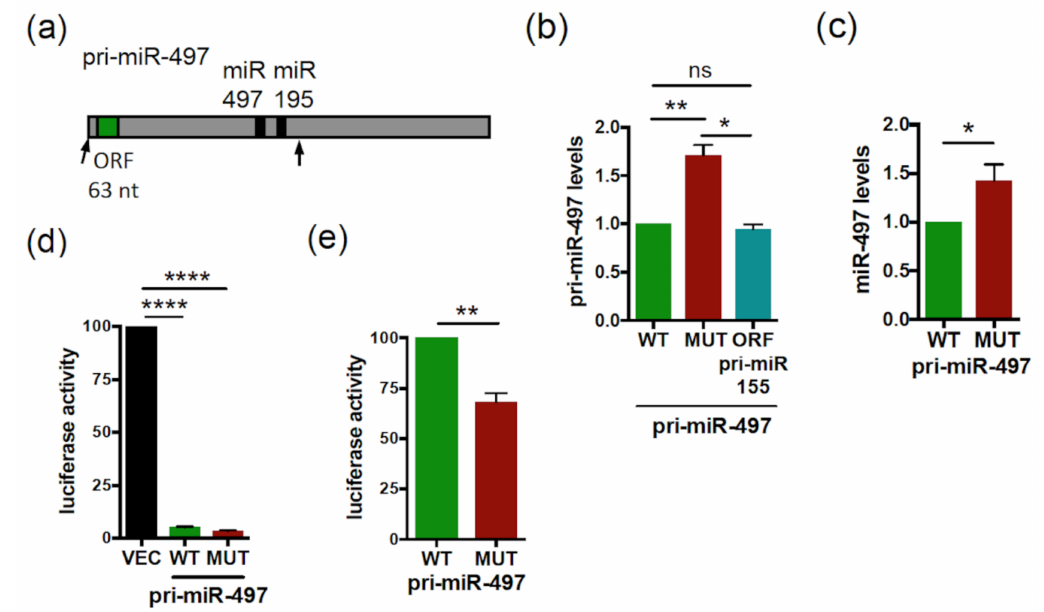
Figure 2. The smORF63 of Human pri-miR-497 regulates the expression levels and activity of pri- miR-497/miR-497. ( a ) Schematic structure of Human pri-miR-497 with the miR-497 (black box) and smORF63 (green box) indicated. The arrows in the pri-miR-497 delimit the sequences cloned and tested. ( b ) Relative expression levels of pri-miR-497 WT or ATG-mutated (MUT) or with the smORF63 replaced by the smORF51 from pri-miR-155 (ORF pri-miR-155) transfected in Hela cells and determined by qRT-PCR. The pri-miR-497 levels were determined and normalized as in Figure 1b. Data are means ± S.E.M. n = 4. ( c ) Relative expression levels of miR-497 processed from WT or MUT pri-miR-497 transfected into Hela cells and determined by qRT-PCR. The miR-497 levels were normalized as in Figure 1b. Data are means ± S.E.M. n = 7. ( d , e ) Relative activity of miR-497 processed from the WT or MUT pri-miR-497 constructs transfected in Hela cells together with the luciferase miR-497 sensor. Cells were tested 48 h post-transfection for dual luciferase assays. ( d ) The luciferase activities of pri-miR-497 transfected cells were compared to that of vector transfected cells (VEC), set to 100. ( e ) The relative luciferase activity of MUT pri-miR-497 was compared to that of WT pri-miR-497 set to 100. Data are means ± S.E.M. n = 8. * p < 0.05, ** p < 0.01, **** p < 0.0001,